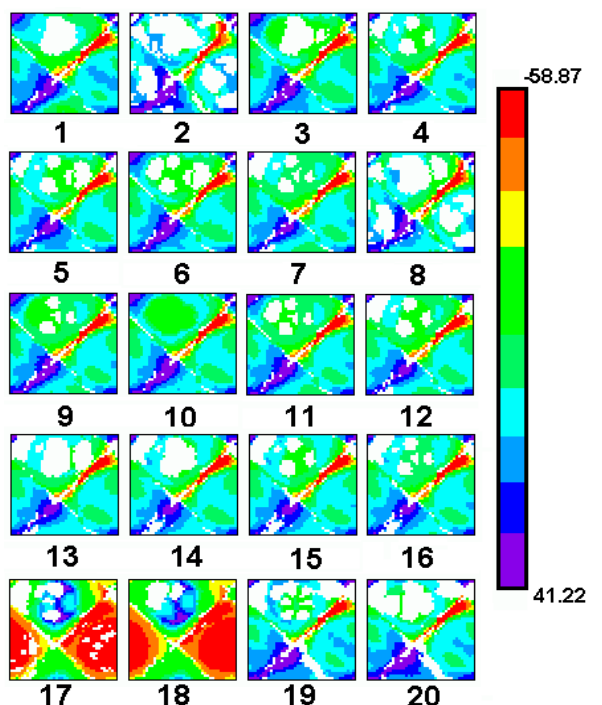
Figure 8. Comparative SOM 40 × 40 maps for 1 – 20 anilides. Colors code MESP values, white color indicates non-active neurons.